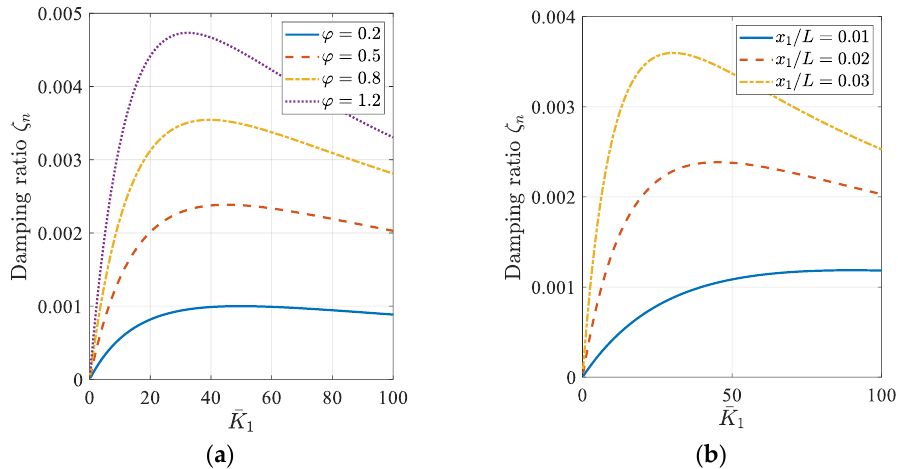
Figure 2. Modal damping curves of a cable with a single HDR damper for ( a ) different loss factor 𝜑 ( 𝑥 1 /𝐿 = 0.02 ) and ( b ) different location 𝑥 1 /𝐿 .